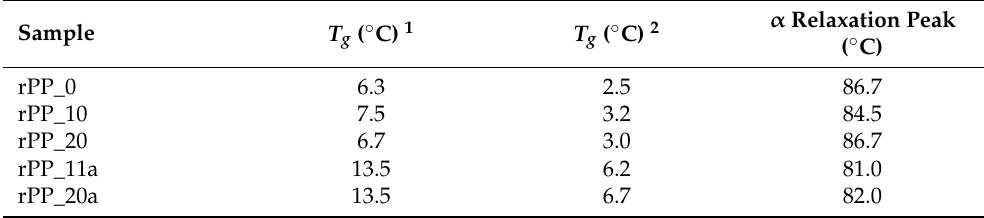
Table 4. Dynamic mechanical analysis (DMTA) results of virgin PP and recycled PP without and with the additive.